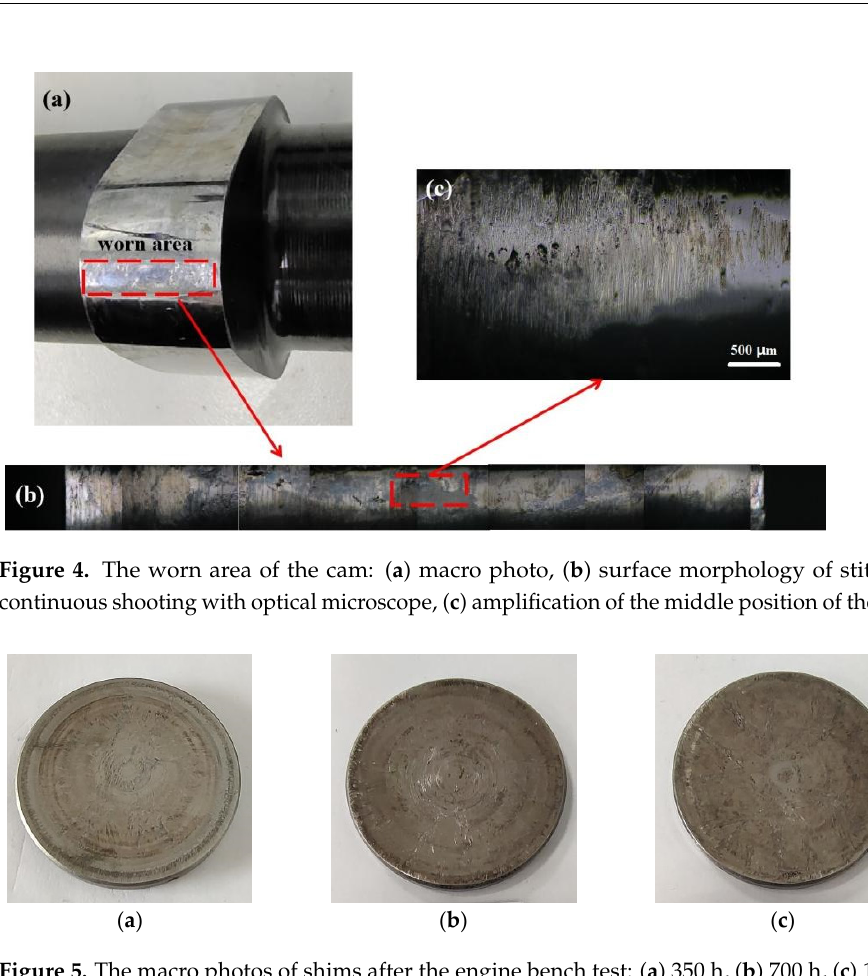
Figure 5. The macro photos of shims after the engine bench test: ( a ) 350 h, ( b ) 700 h, ( c ) 1000 h.